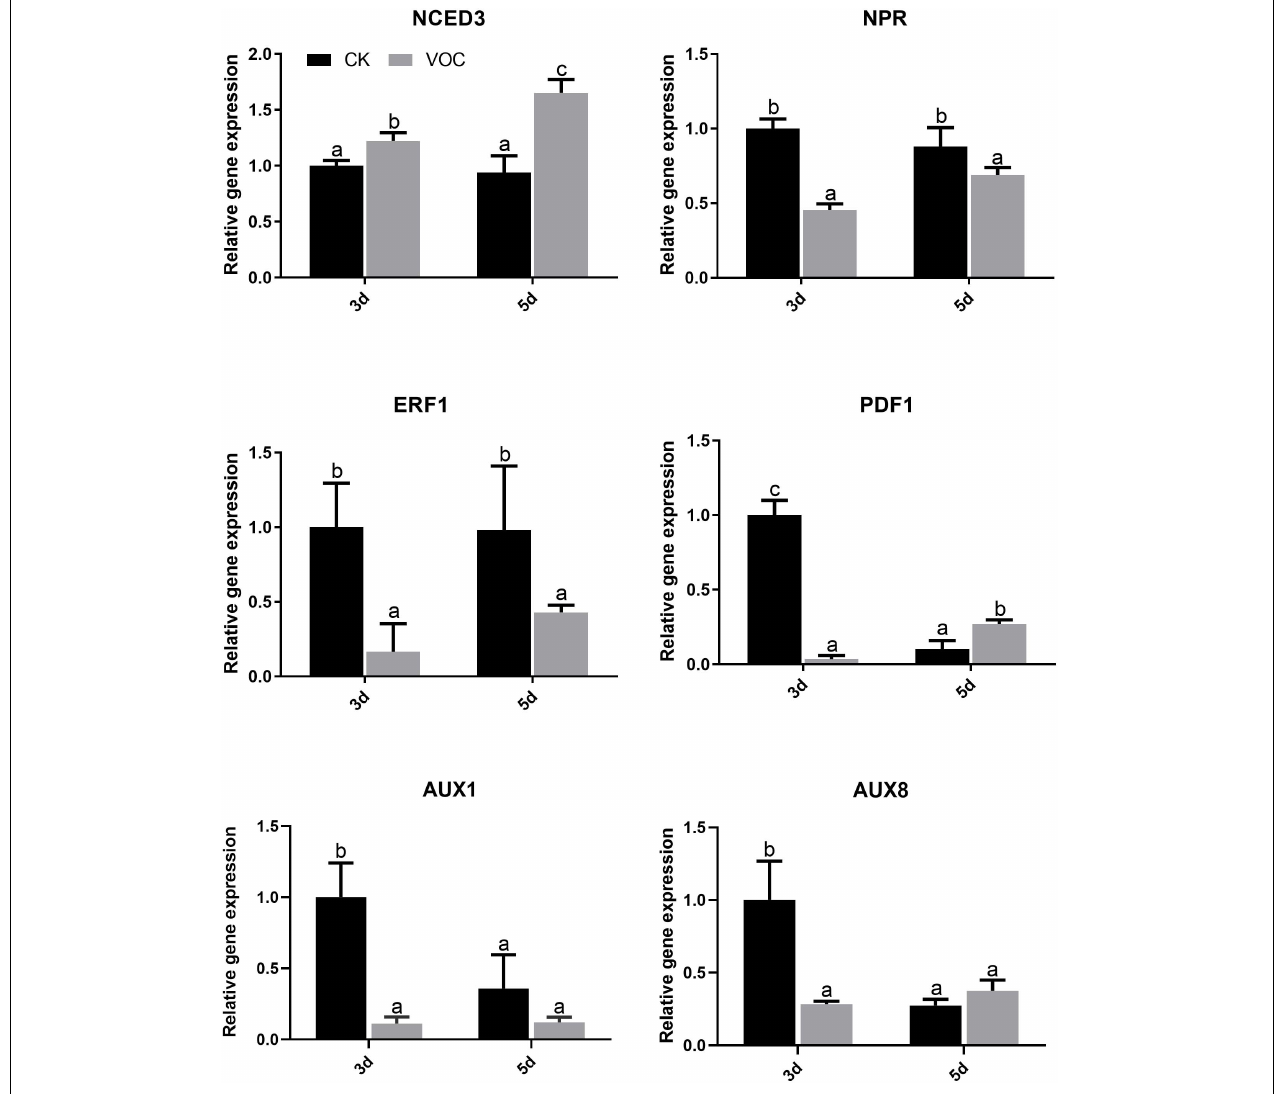
FIGURE 5 | Effects of VOCs from Rahnella aquatilis JZ-GX1 on the transcriptional expression of genes related to hormone biosynthesis in Arabidopsis thaliana. One-way ANOVA was performed, and Duncan’s post hoc test was applied. Different letters indicate statistically significant differences ( p < 0.05) among treatments.